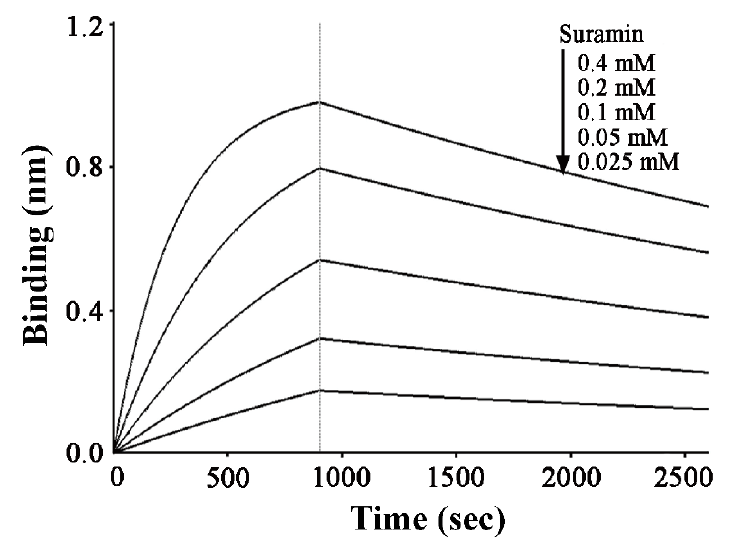
Figure 1. BLI assays of suramin binding to hRKIP.